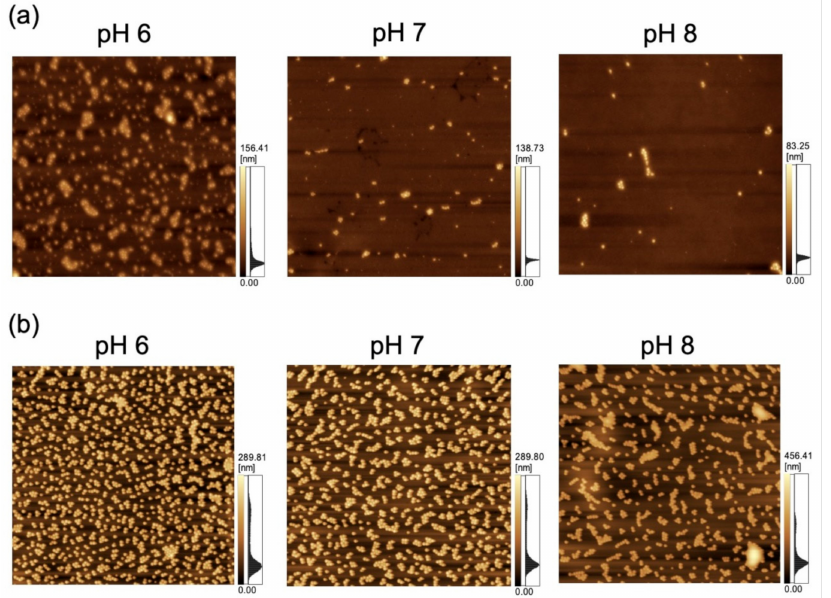
Figure 7. Atomic force microscopy images of a polydimethylsiloxane-based microchannel exposed to variable-pH dispersions of ( a ) 100-nm (scan area = 8 µ m × 8 µ m) and ( b ) 250-nm nanoparticles